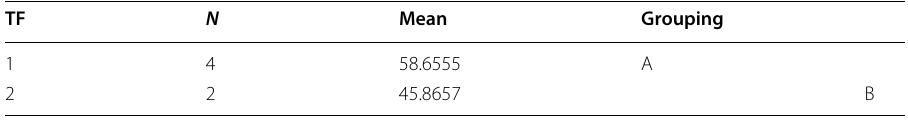
N sample size. Means that do not share a letter are significantly different